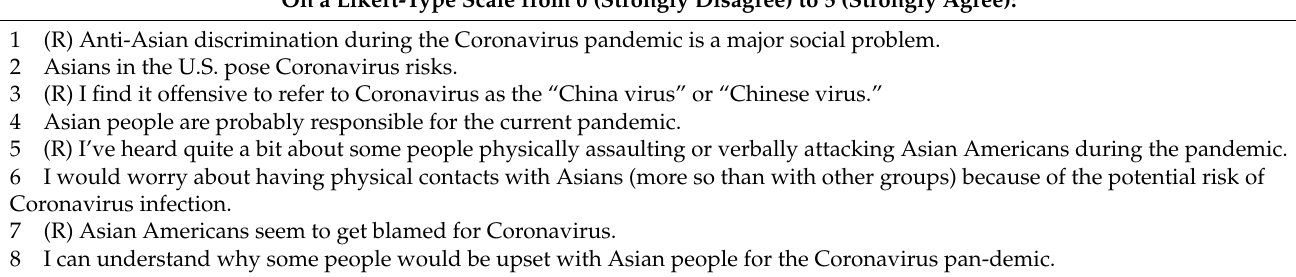
Table 3. The Coronavirus Asiaphobia Scale ( ω =